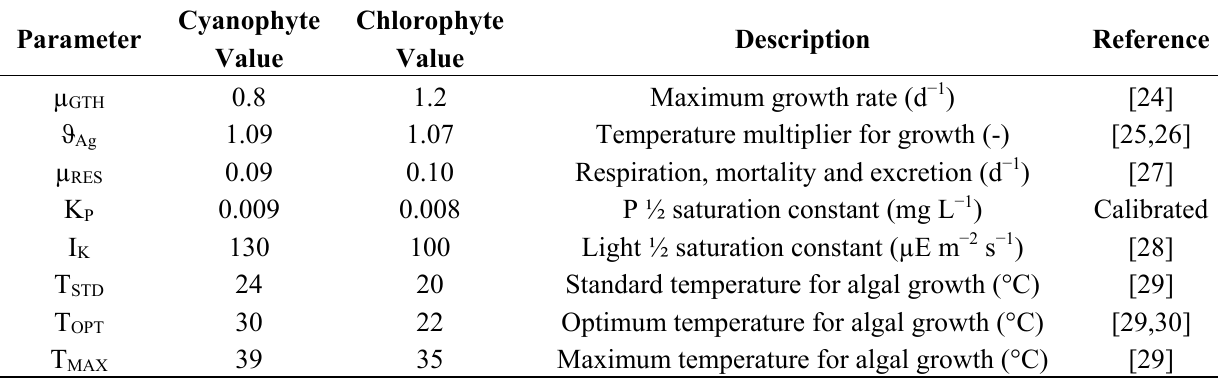
Table 1. Phytoplankton group parameters that differentiate the response to ecophysiological drivers in the ELCOM-CAEDYM model set